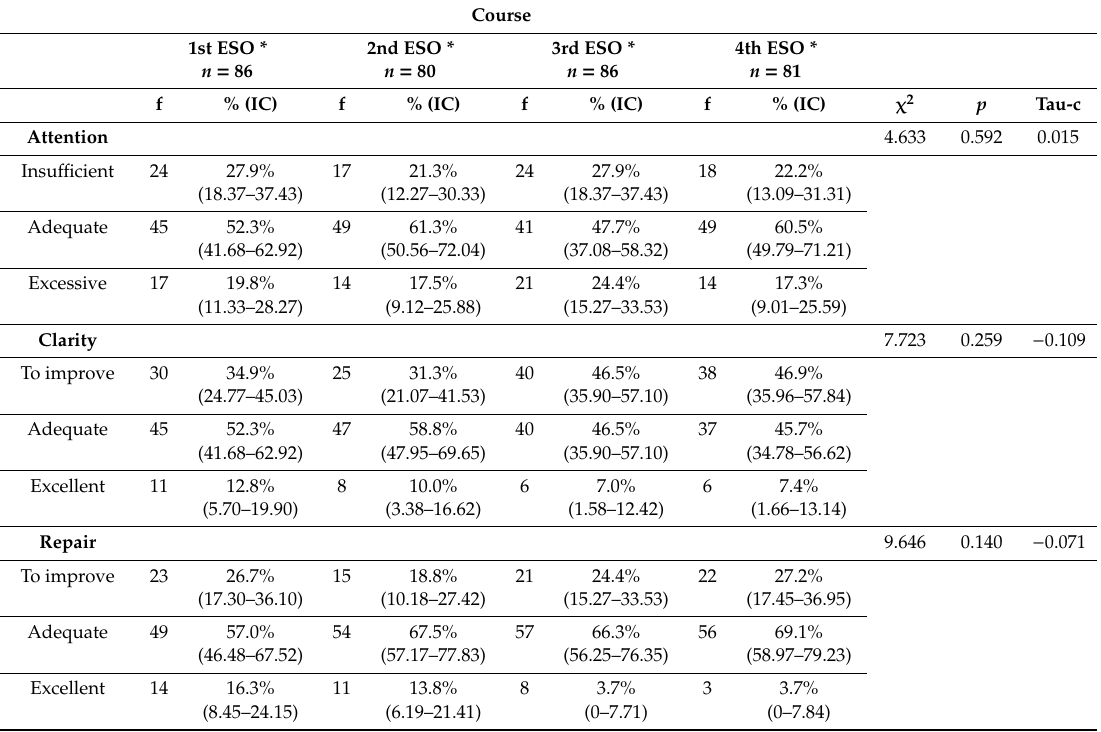
Table 3. Analysis results for the emotional Attention, Clarity, Repair dimensions according to the course of the